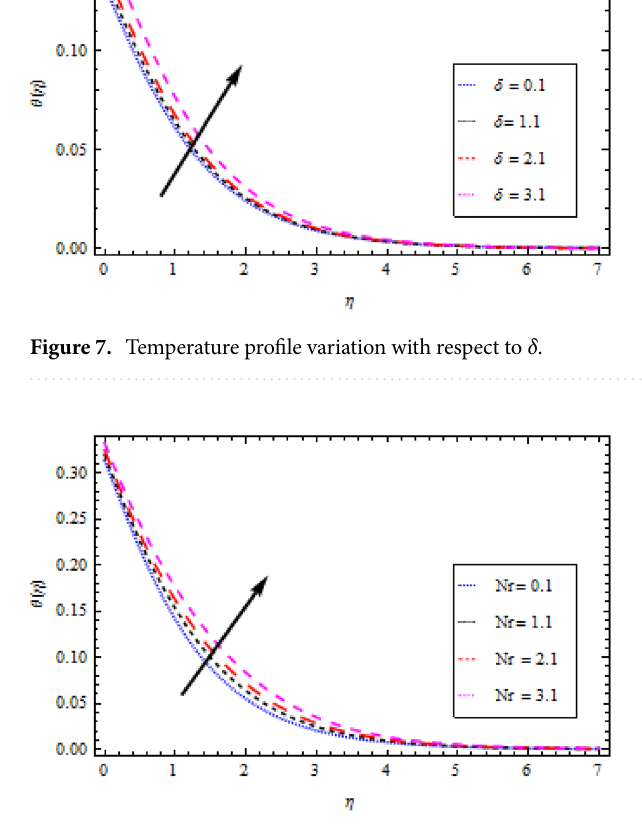
Figure 8. Temperature profile variation with respect to N r .